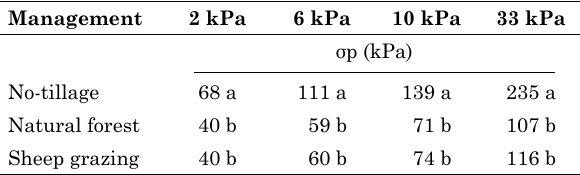
Table 3. Preconsolidation pressure values (σp) in soil under varied managements at different water retention tensions